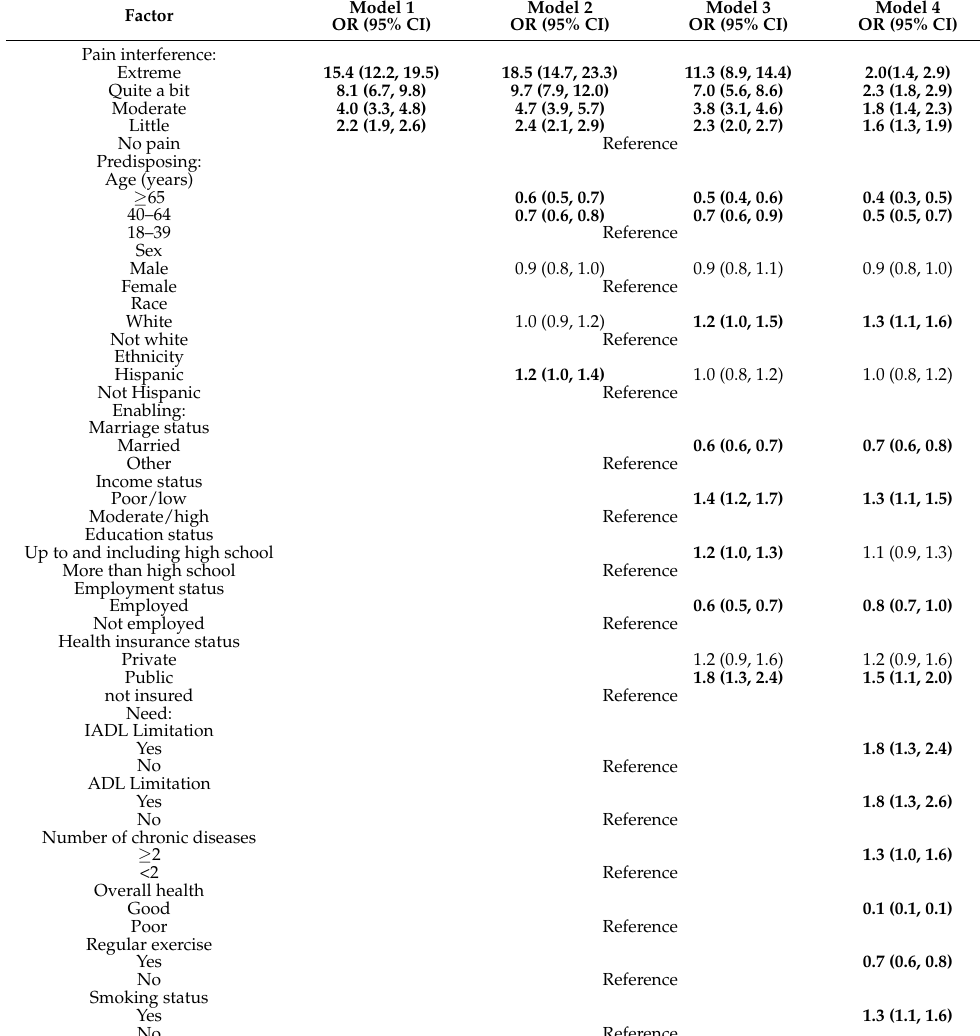
Table 2. Association of perceived pain interference with poor (vs. good) psychological wellbeing in United States adults. Factor Model 1 OR (95% CI) Model 2 OR (95% CI) Model 3 OR (95% CI) Pain interference: